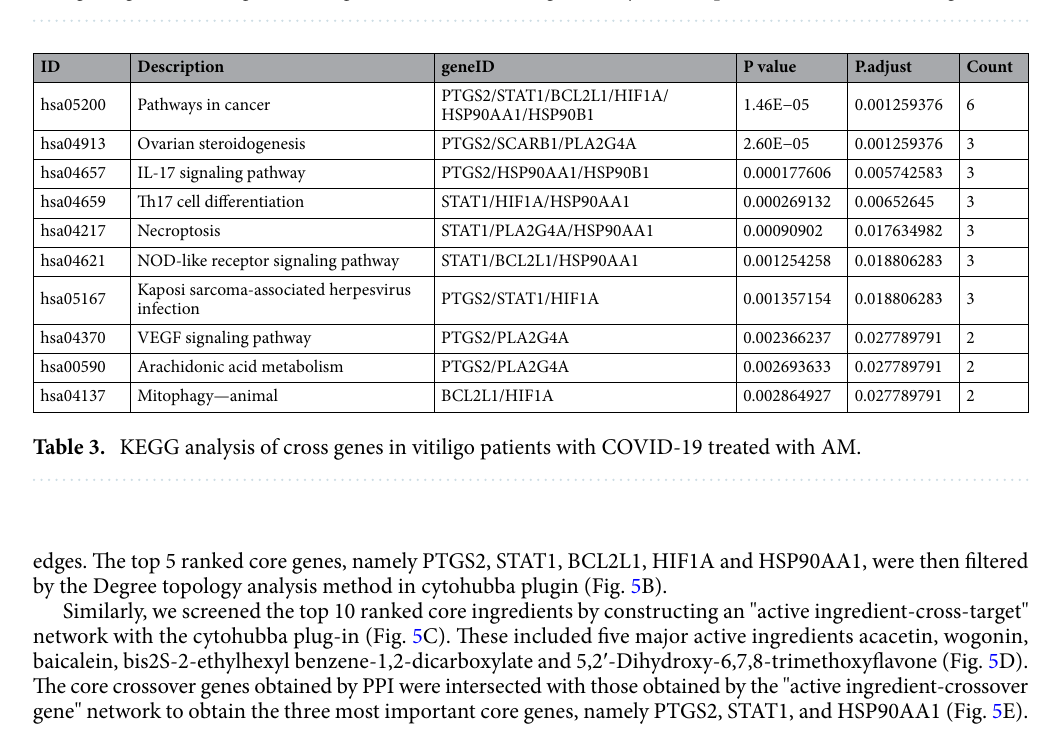
Figure 4. GO and KEGG pathway analysis of cross-targets of Astragalus membranaceus for vitiligo and COVID-19. ( A ) Analysis of the top 10 most significant GO enrichment functions. They are involved in various biological processes (red section), molecular functions (blue section) and cellular components (green section). ( B ) GOChord plot of the top 10 ranked KEGG pathways analysed belonging to crossover genes. Genes are linked by coloured bands to the terms they are assigned to. Genes are ranked according to the observed log fold change (logFC), with log-fold changes shown in decreasing intensity in red squares next to the selected gene.